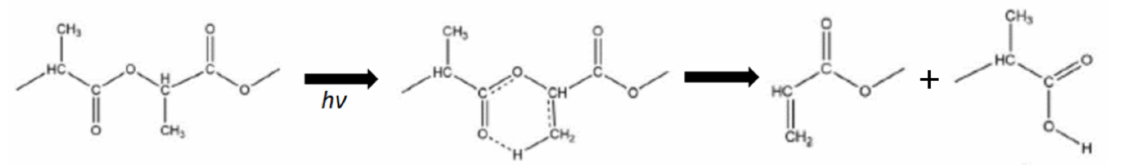
Figure 10. Scheme of photodegradation via Norish II mechanism adapted from